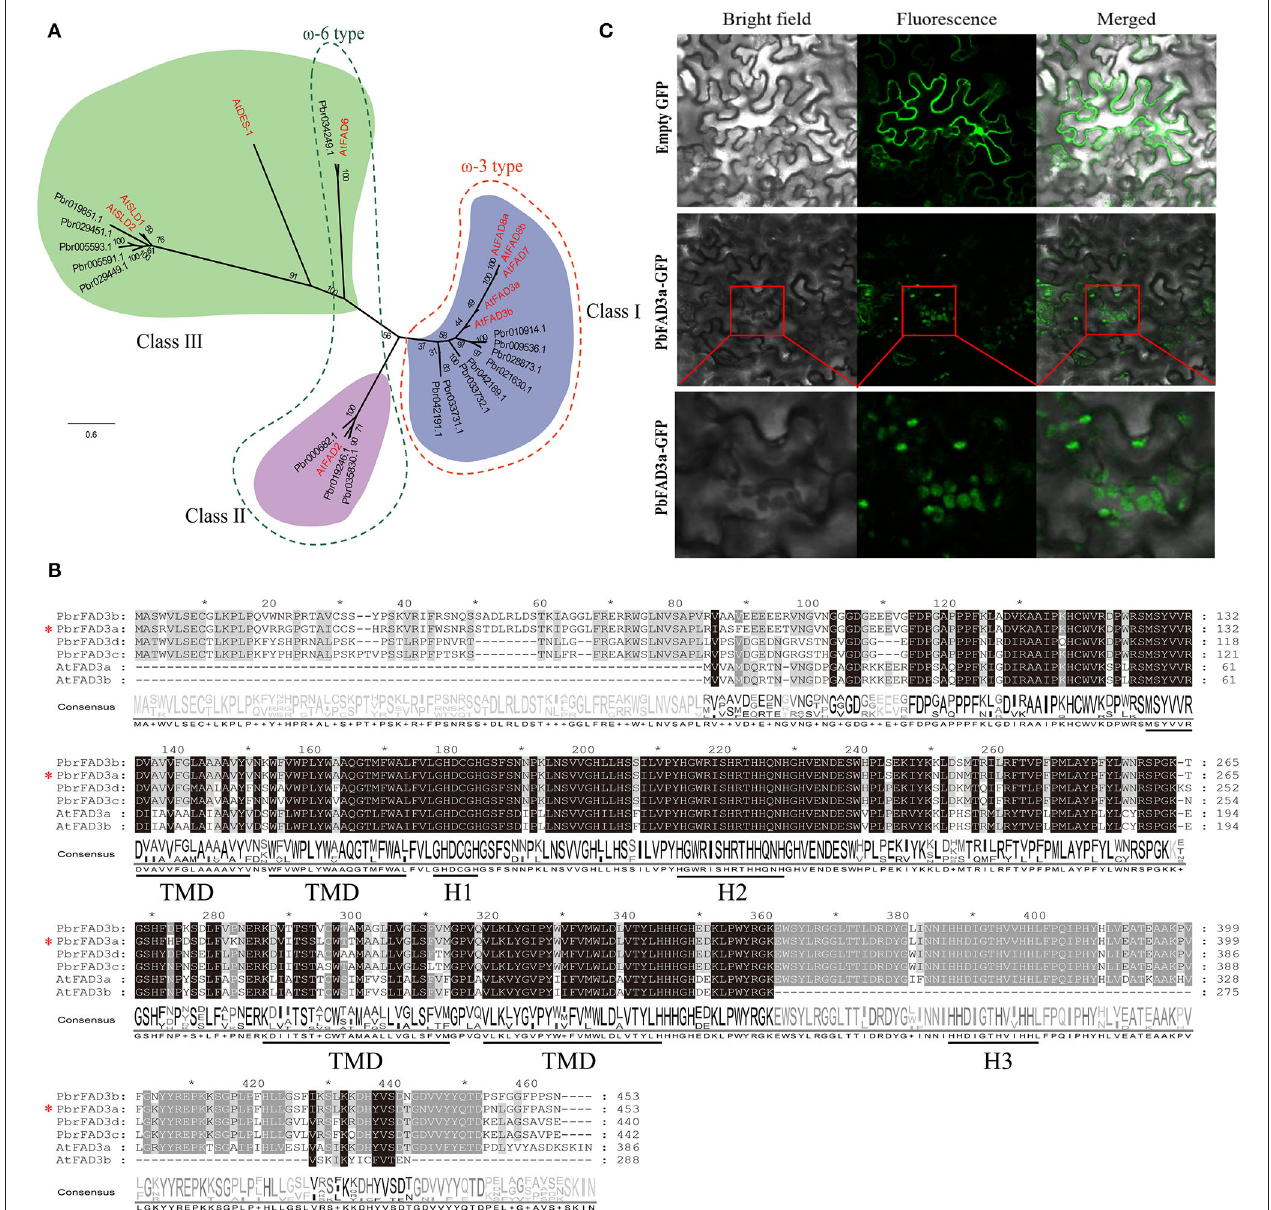
FIGURE 5 | Phylogenetic, expression analysis, and subcellular localization of PbFADs. (A) Phylogenetic analysis of PbFADs in white pear and Arabidopsis. Alignments were calculated with Clustal X, and the phylogenetic tree was constructed using Figtree v1.4.3 software with the maximum likelihood method (bootstraps = 1,000). The position of PbFAD3a ( Pbr021630.1 ) is indicated by an asterisk. (B) Sequence alignment of ω -3 FADs in pear and Arabidopsis. The sequence was aligned using Clustal X and displayed by Jalview software. Identical residues are shown on a background of black and gray. The three conserved histidine clusters (H1-H3) and the four transmembrane domains (TMD) are underlined. (C) Subcellular localization of PbFAD3a in tobacco